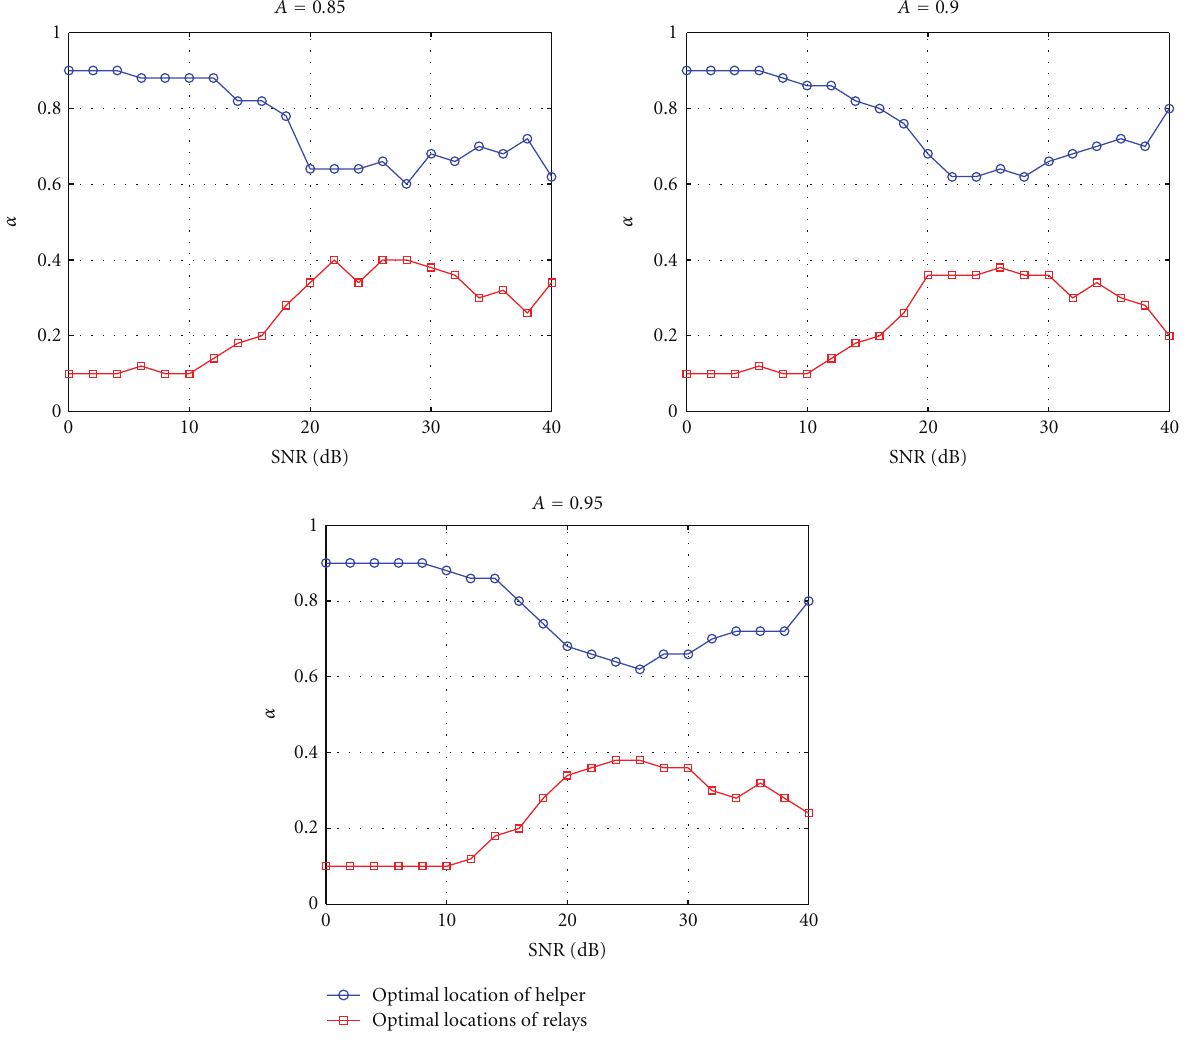
Figure 10: Simulated optimal locations of the intermediate fusion helper and relays using MRC receiver in Rayleigh fading channels ( β = 3 . 5, d =